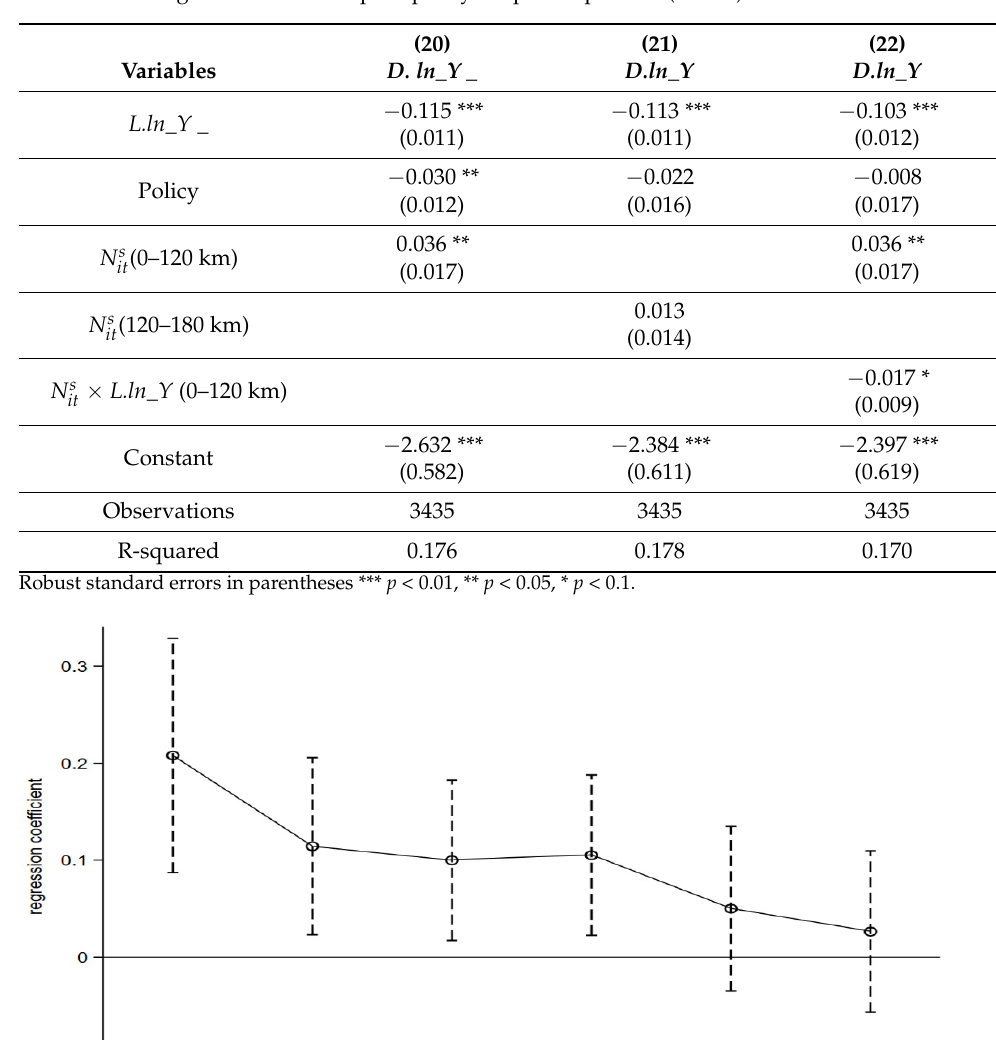
Table 4. Convergence effect of the pilot policy in spatial spillover (Plan 2).